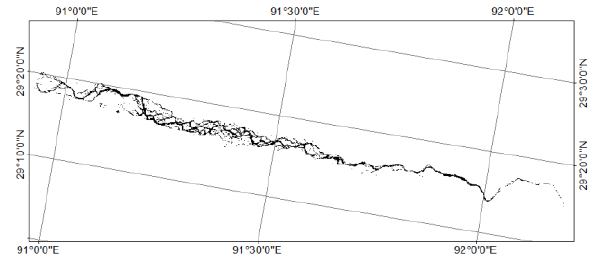
Figure 6. River extraction result using MLC